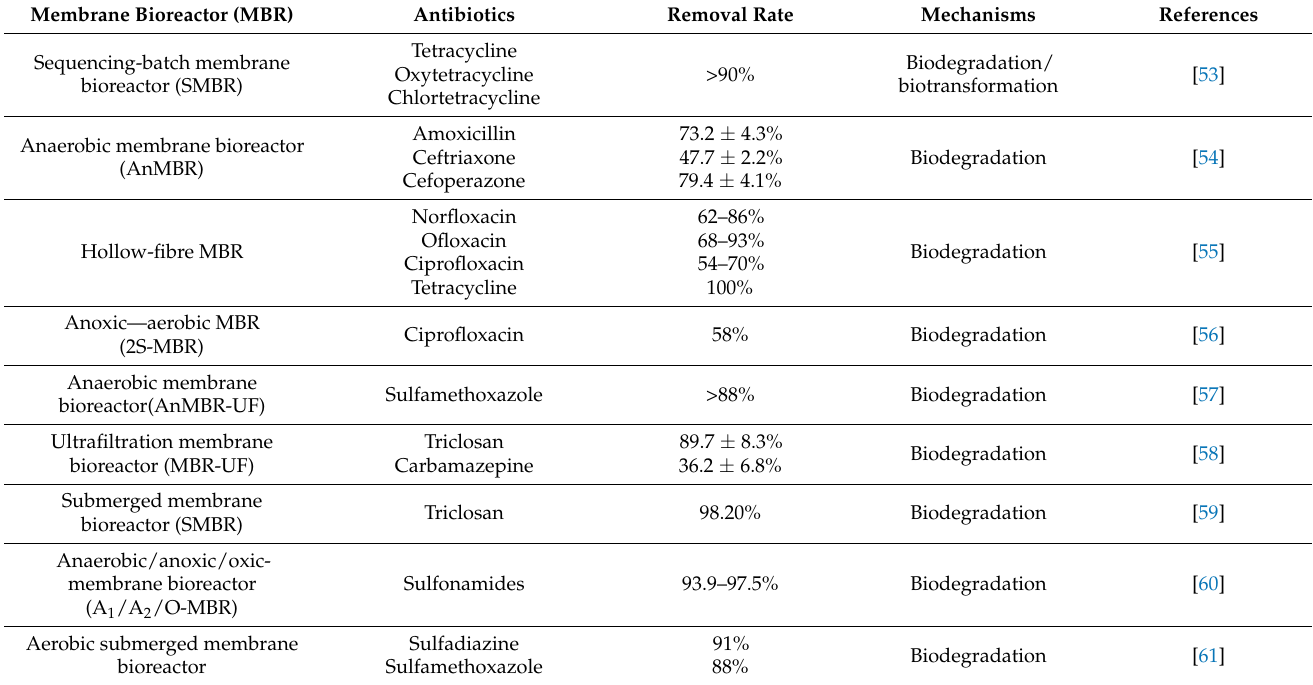
Table 1. The performance of antibiotics removal by using different membrane